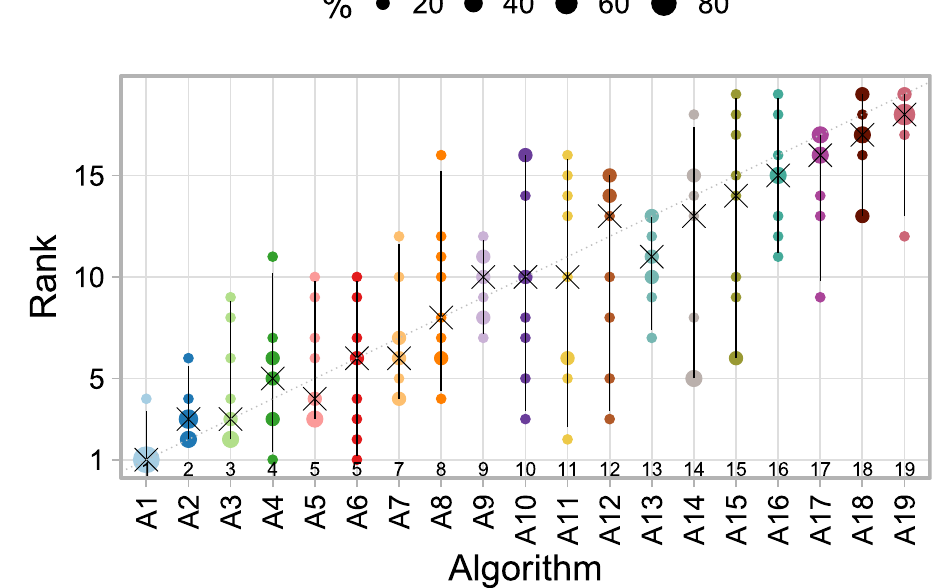
Figure 16. Blob plots for visualizing ranking stability across tasks. Consensus rankings above algorithm names highlight the presence of ties.